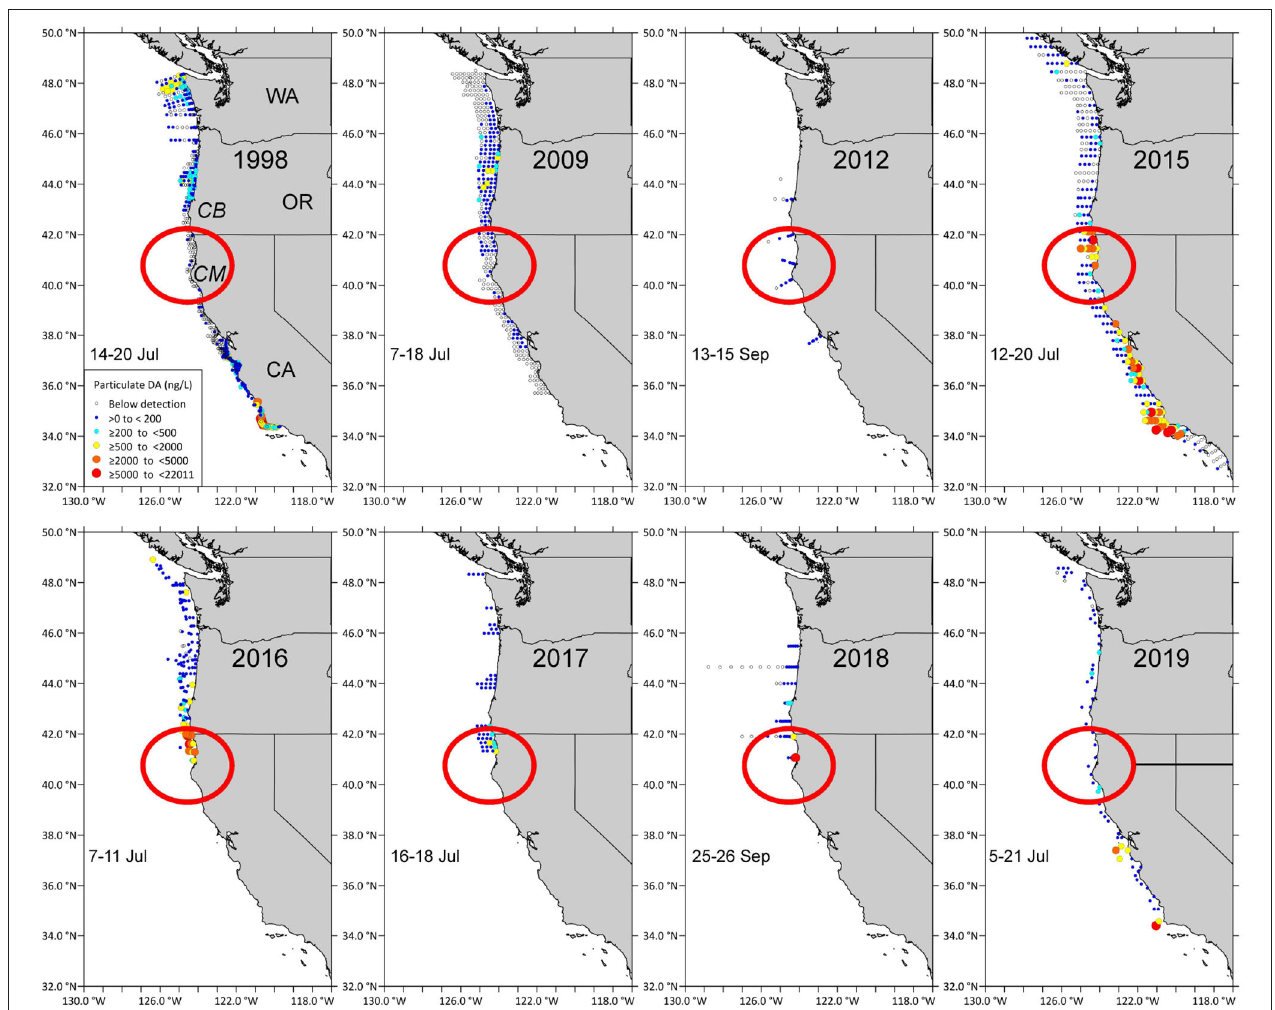
FIGURE 2 | Domoic acid first appeared at the “hotspot” site between Cape Blanco (CB) in OR and Cape Mendocino (CM) in 2015 (red circle). Particulate domoic acid concentrations (ng/L; see legend inside the 1998 map) at stations sampled during summer cruises in 1998, 2008, 2012, 2015, 2016, 2017, 2018, 2019. The dates when stations in the red circled area that is centered around Trinidad, California, were sampled are shown on each